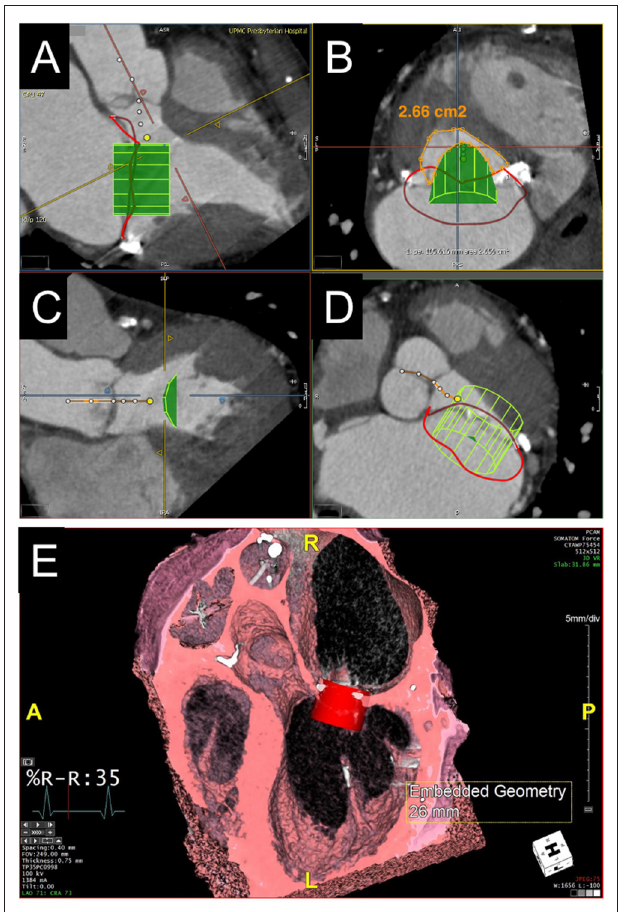
FIGURE 4 | Evaluation of predicted neo-LVOT area by CT. (A–D) LVOT assessment for valve-in-MAC TMVR. Virtual implantation of a cylindrical transcatheter valve coaxial to the mitral annulus during a systolic phase (A) and delineation of the LVOT centerline yields a short-axis view of the predicted neo-LVOT area ( B , orange ), which measures 2.66 cm 2 and predicts a low risk of LVOT obstruction with TMVR in this case. (E) Volume rendered image showing a capacious neo-LVOT area in a case under consideration for valve-in-ring TMVR.